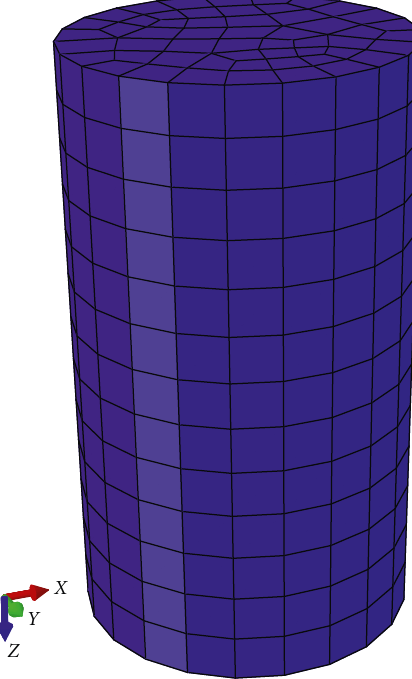
Figure 4: Calculation model of the